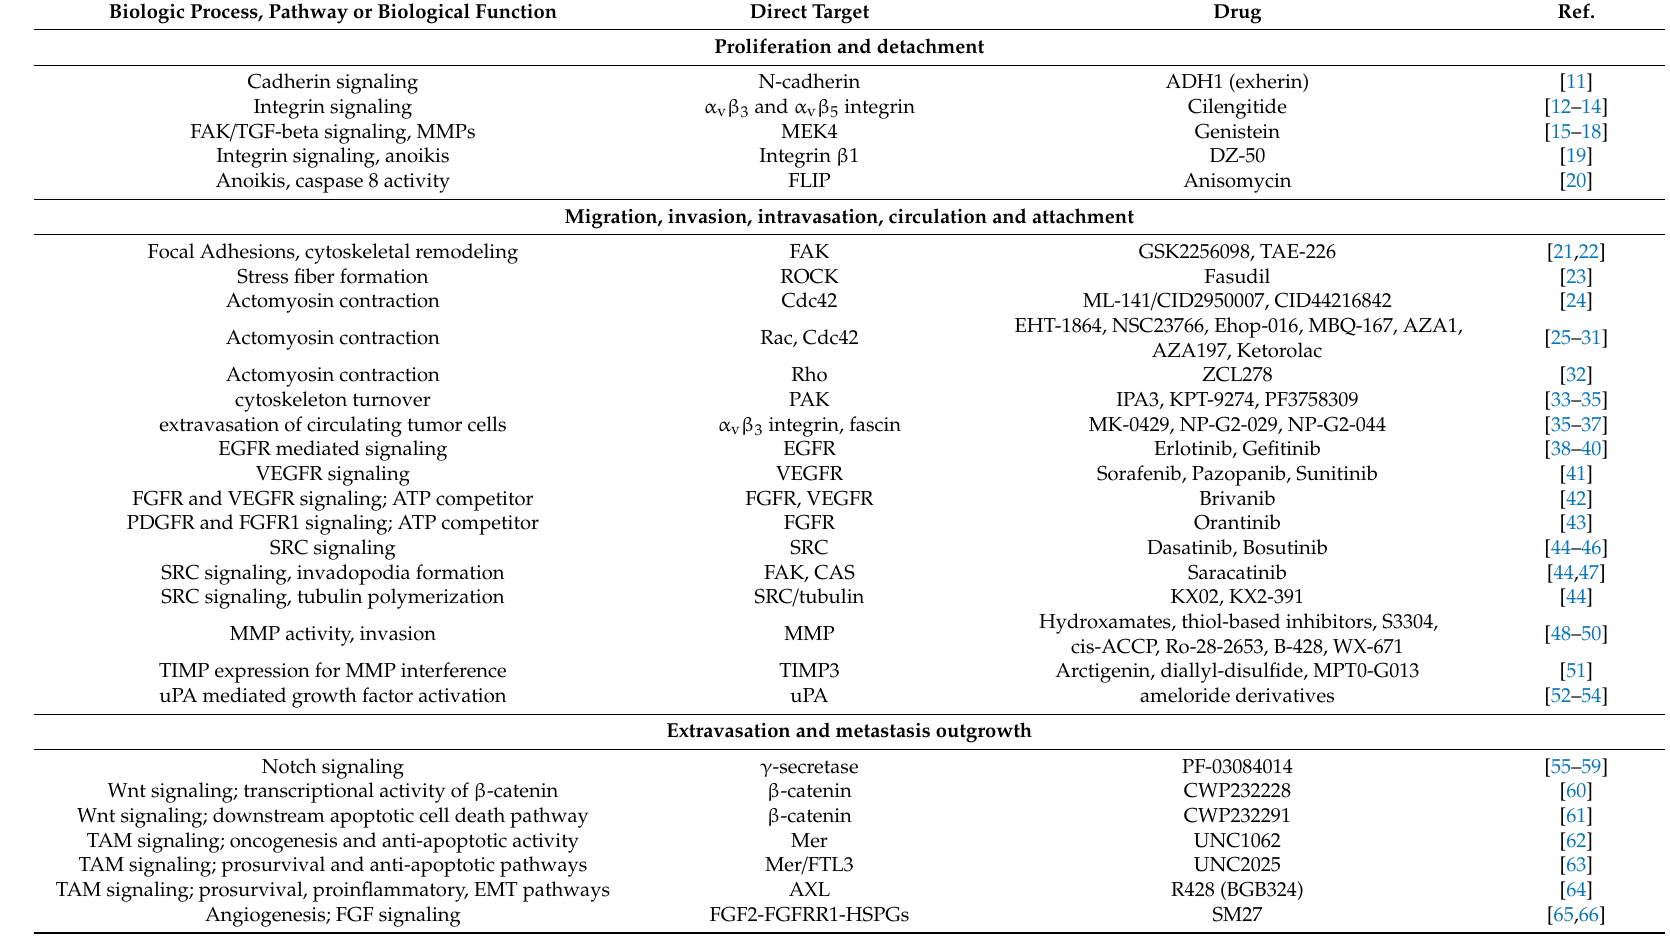
Table 1. The table summarizes the small molecule drugs and their targets discussed in this